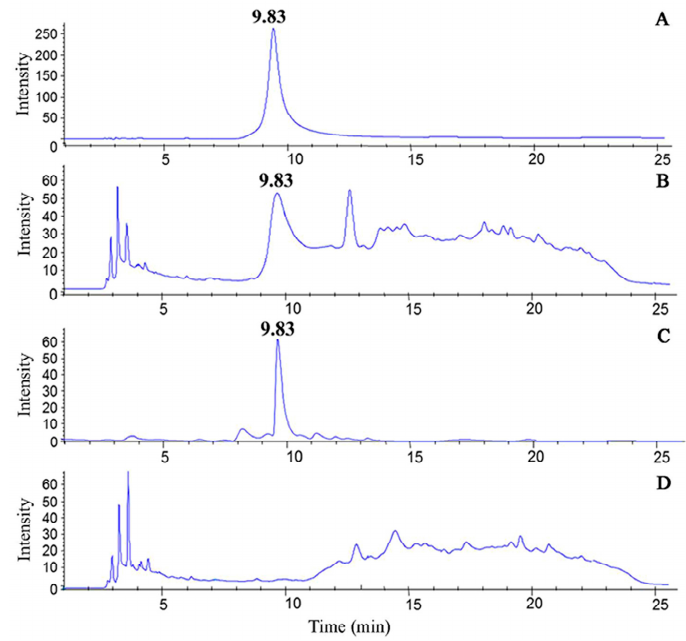
Figure 1. Chromatograms of nicotine in cigarette smoke extract (CSE) using high-performance liquid chromatography (HPLC). The retention time of nicotine occurs at 9.83 min. ( A ) Nicotine standard, ( B ) CSE, ( C ) nicotine section of CSE (CSE-N), and ( D ) nicotine-free section (CSE-O). Int. J. Environ. Res. Public Health 2017 , 14 , 1221